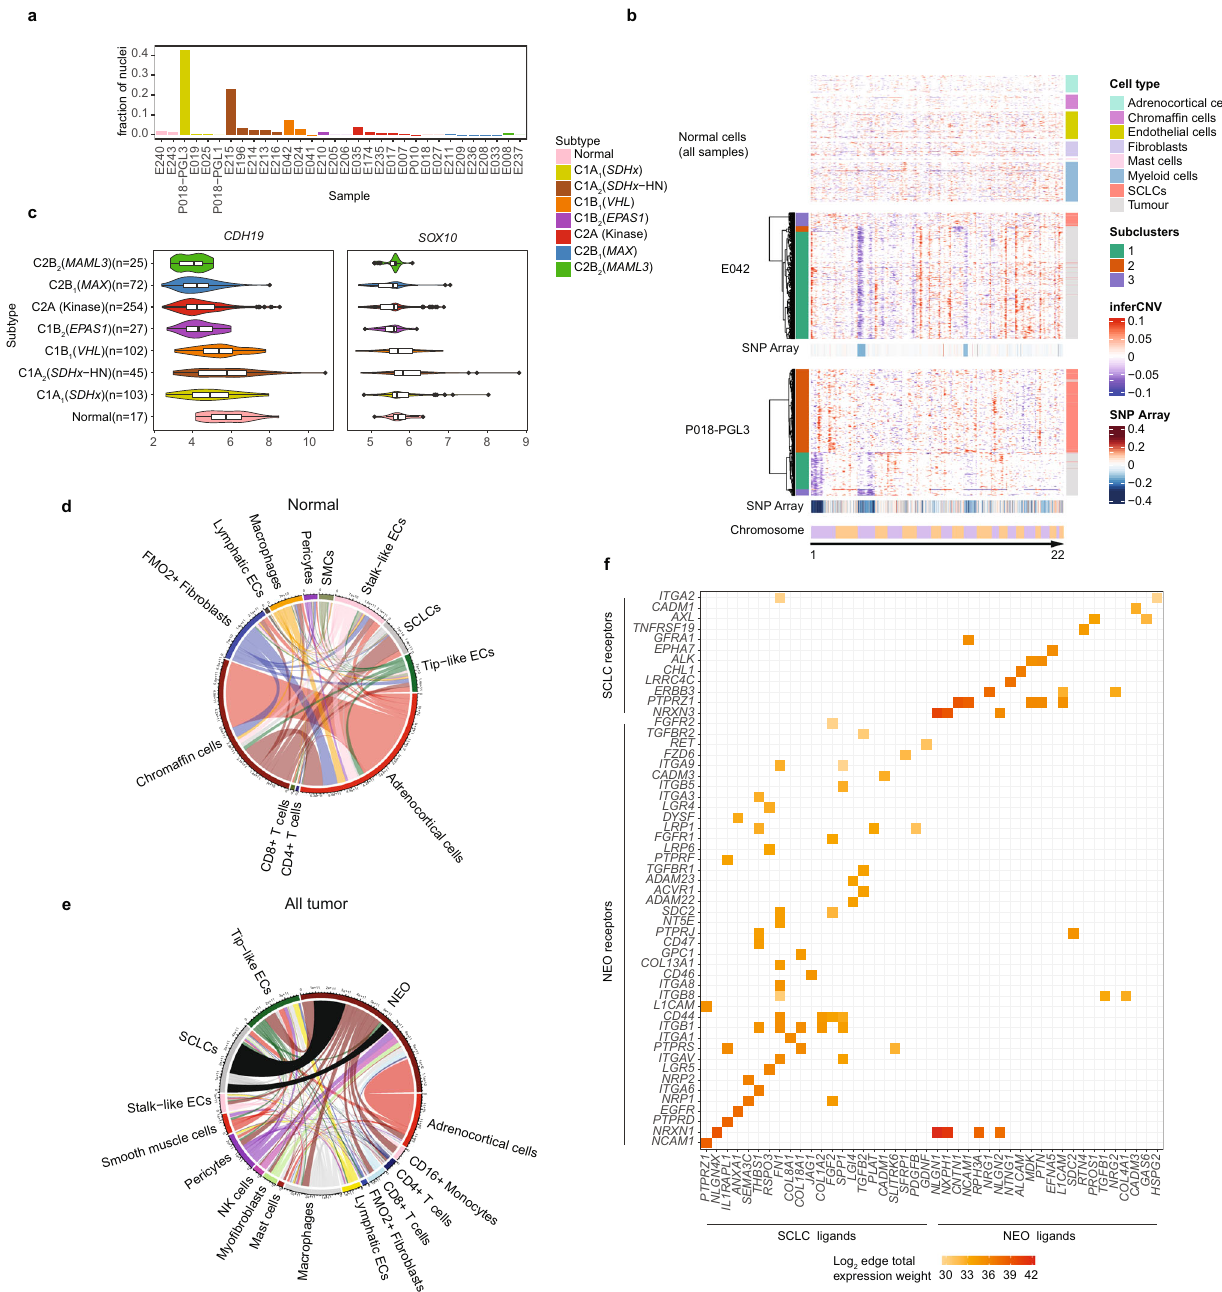
Fig. 5 | SCLCs and cell-signaling in PCPG and NAM tissues. a Fraction of SCLCs among all cells detected in PCPG tumors by snRNA-seq. b Inferred copy-number and clustering of NEO and SCLC populations in two PCPG tumors (E042, P018- PGL3) (bottom panels; clustered tumor cells and SCLCs, top panel; non-neoplastic cell types excluding SCLCs from all tumors and normal tissues). InferCNV scale= modi fi edexpression,SNParrayscale=logratio. c Gene-expressionofSCLCmarker genes CDH19 and SOX10 in bulk-tissue data (nSamples=645, the lower and upper hingesofeachboxplotcorrespondtothe fi rstandthirdquartiles,respectively,and the median value is marked. The whiskers extend to the largest and smallest value